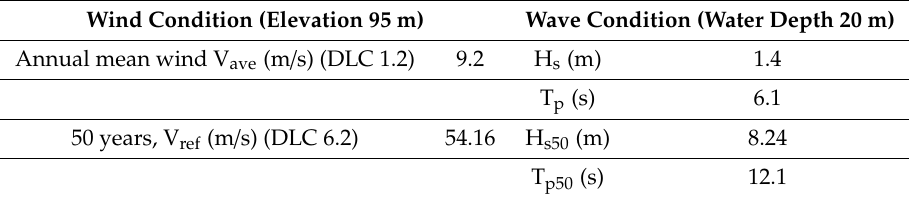
Table 2. The wind and wave conditions at the Zhangbin Industrial Zone project. DLC: Design Load Case.